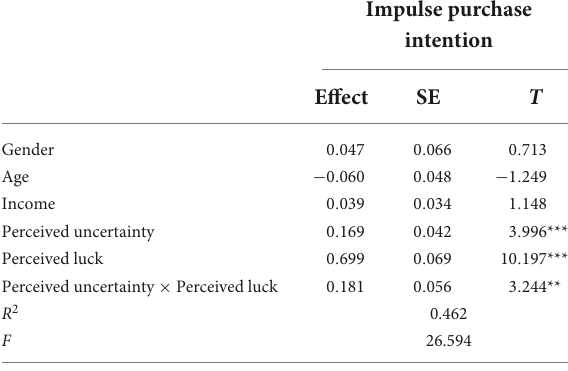
TABLE 7 A moderating model test of perceived luck.